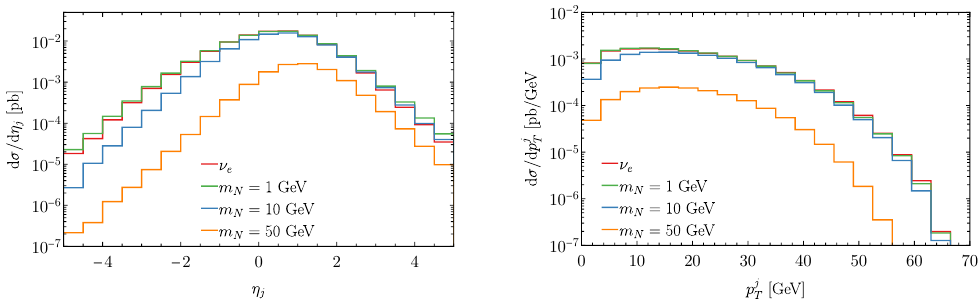
distributions of mono-jet production at T